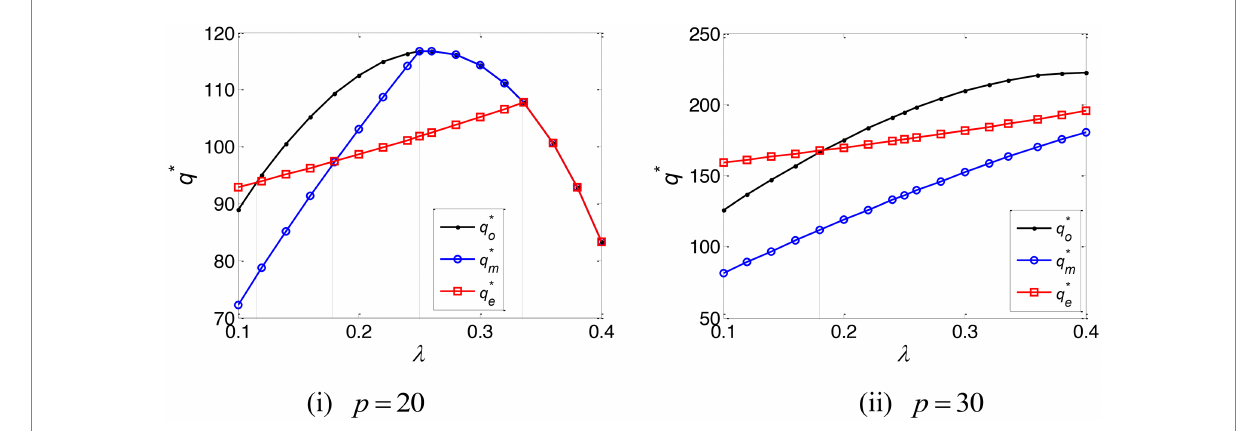
FIGURE 4 The optimal ordering quantity of the online